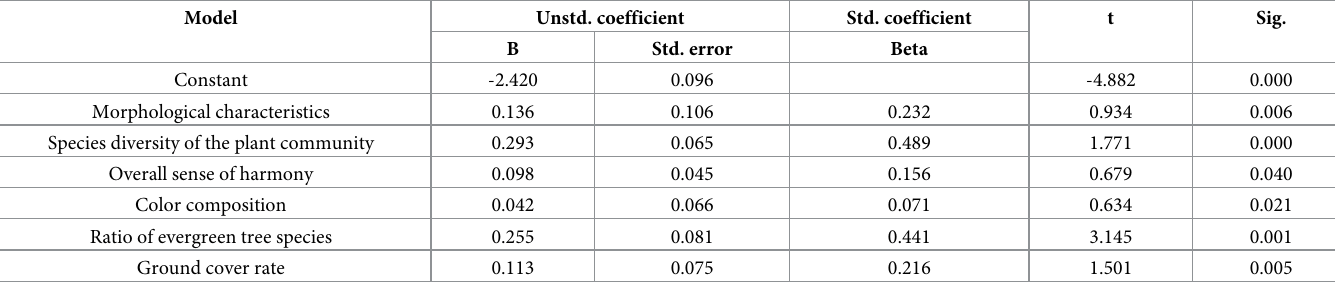
Table 4. Regression coefficients of the landscape factors for plant beauty.